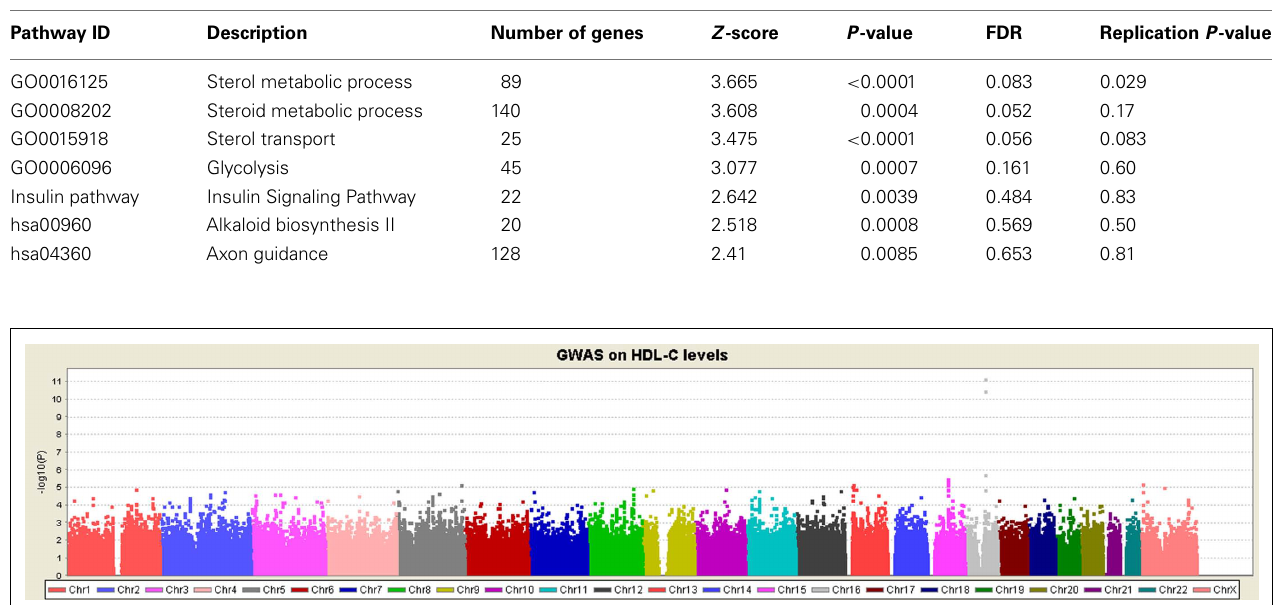
Table 1 | The most significantly associated pathways in the discovery GWAS data set.